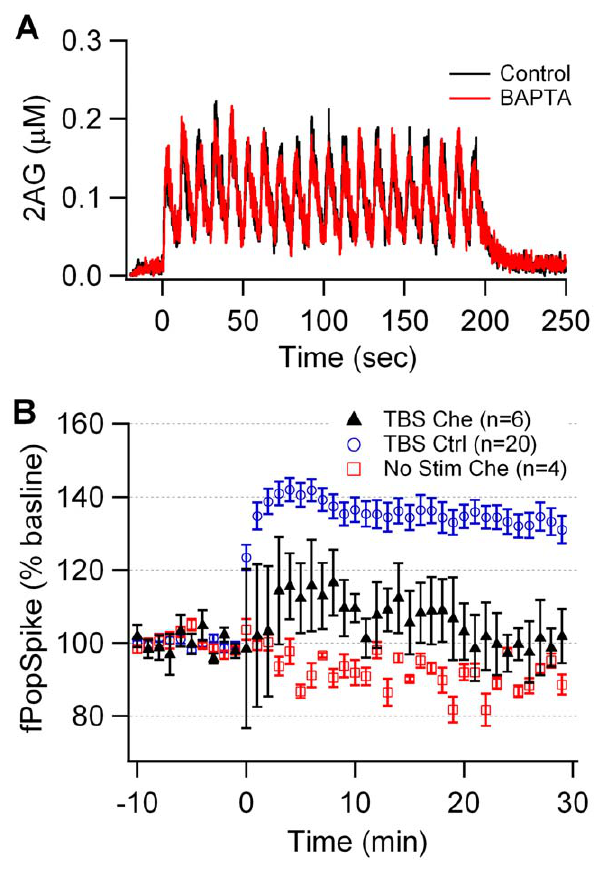
Figure 8. Validation of the model. (A) 2AG production is not altered by 10 m M BAPTA included in the simulation, which is consistent with the observation that 10 m M BAPTA does not block 20 Hz LTD. (B) The PKC inhibitor chelerythrine (Che) blocks LTP induced by theta burst stimulation (TBS) but does not produce a non-specific decay in the field population spike in striatal